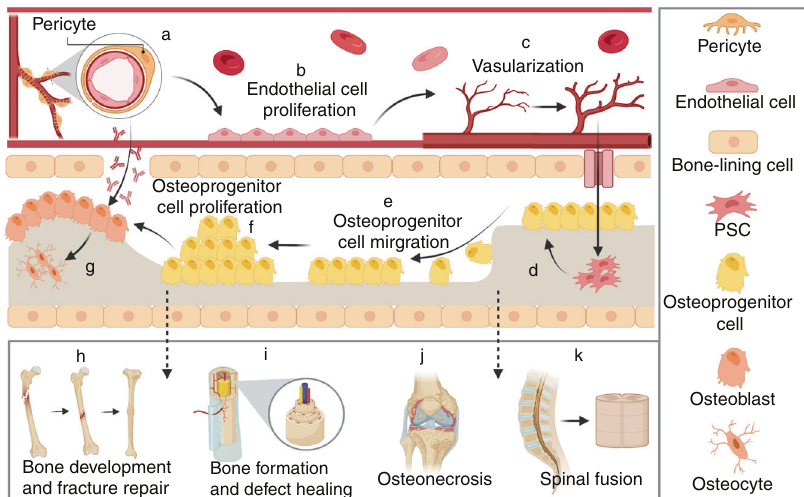
Fig. 4 Schematic diagram proposing the role of pericytes in angiogenesis and bone repair. a Pericytes, located in the basement membrane of blood vessels, are the cells that surround endothelial cells in the capillary and veins of the body. b Pericytes communicate with endothelial cells through physical contact and paracrine signals, monitoring and stabilizing the maturation of endothelial cells. c Pericytes promote angiogenesis, which has an important role in maintaining intravascular homeostasis. d – k Pericytes are also an important source of stem cells for bone regeneration with osteogenic potential. d Mediating the differentiation of perivascular stem cells (PSCs) into osteoprogenitor cells. e Promoting the migration of osteoprogenitor cells. f Inducing the proliferation of osteoprogenitor cells. g Inducing the differentiation of osteoblasts via paracrine mode. h – k The proposed role of PSCs in bone development and fracture repair ( h ), bone formation and defect healing ( i ), osteonecrosis ( j ), and spinal fusion ( k ) as discussed in the